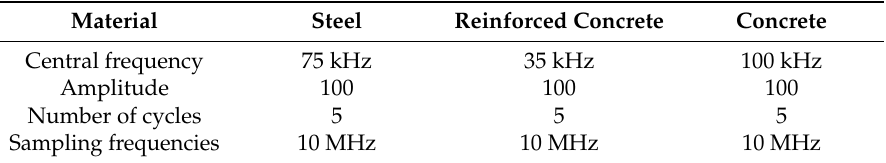
Table 2. The parameters of the incident waves.